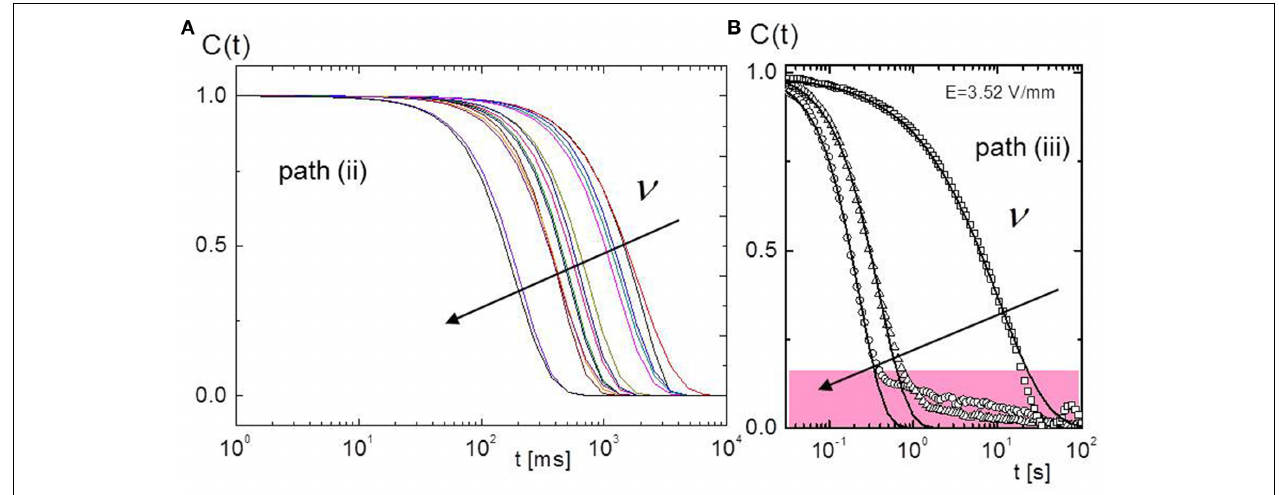
FIGURE 6 | Dynamic light scattering correlation functions for the different paths: (A) the off-critical path (ii) and (B) the path (iii) at critical field strength. The arrow indicates the decrease of an applied